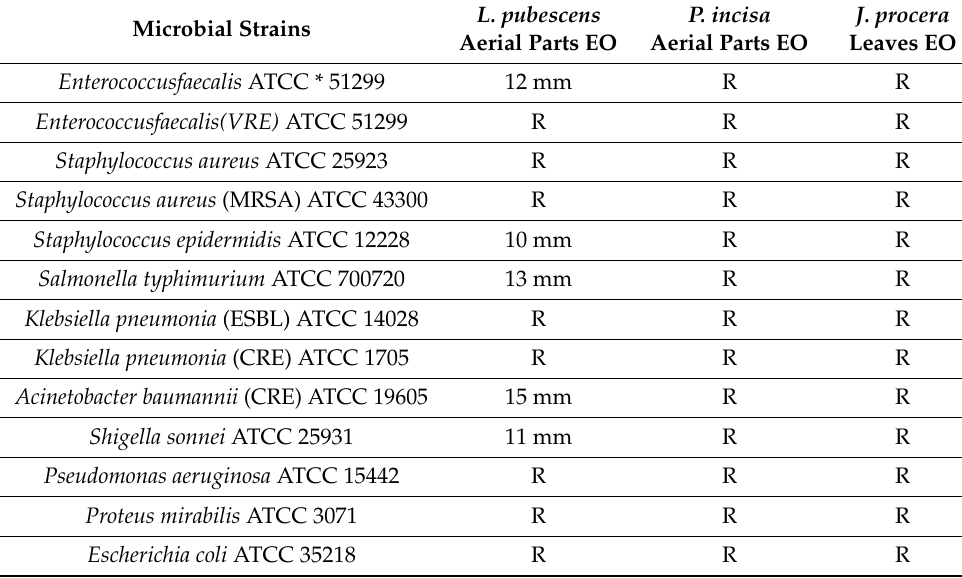
Table 2. Antimicrobial evaluation of essential oils (EOs) in agar diffusion assay (200 µ g/well), R =